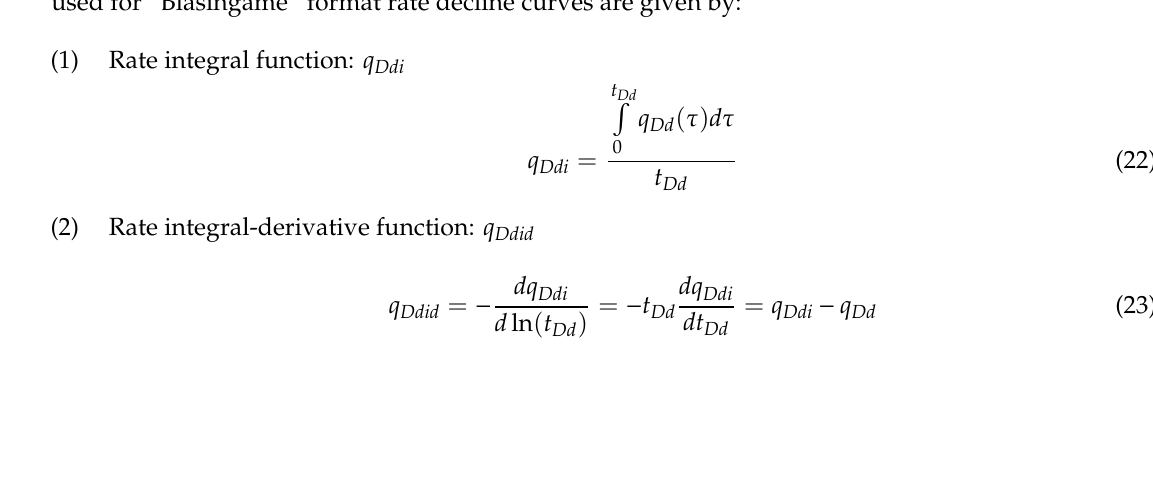
Figure 4. Validation of a finite-conductivity fracture with an azimuth angle in an anisotropic reservoir.